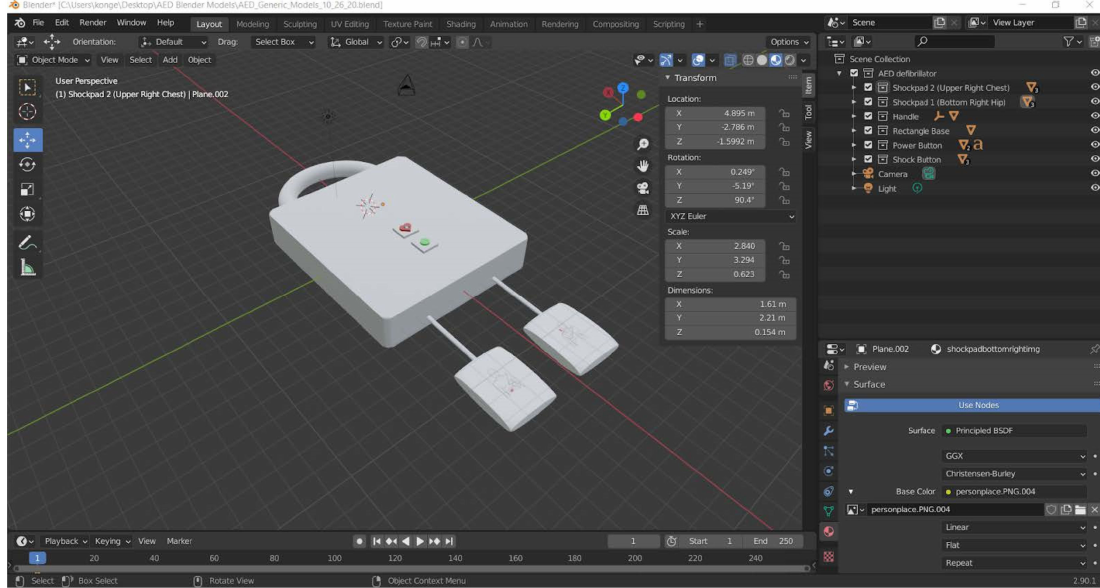
Figure 8. Early low-fidelity AED design in